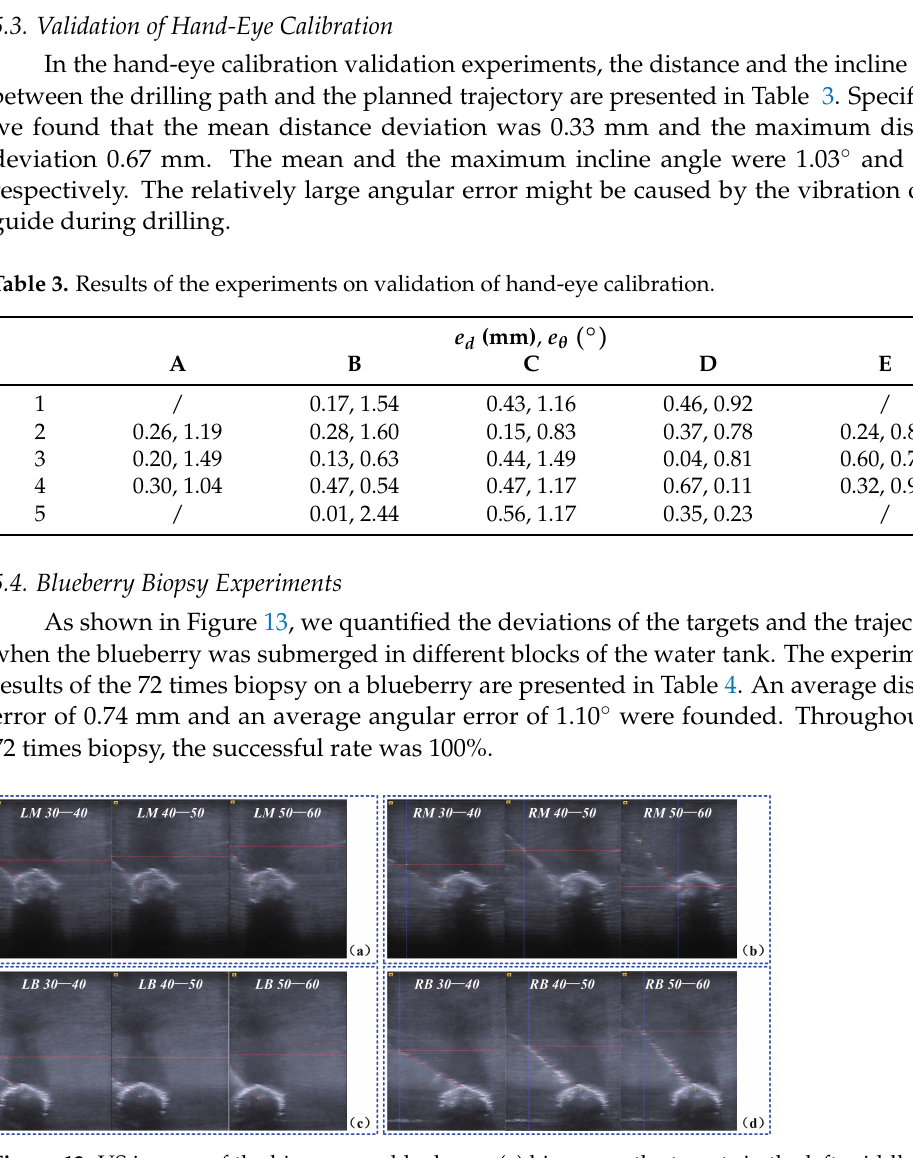
Figure 13. US images of the biopsy on a blueberry. ( a ) biopsy on the targets in the left middle block from three different angles; ( b ) biopsy on the targets in the right middle block from three different angles; ( c ) biopsy on the targets in the left bottom block from three different angles; ( d ) biopsy on the targets in the right bottom block from three different